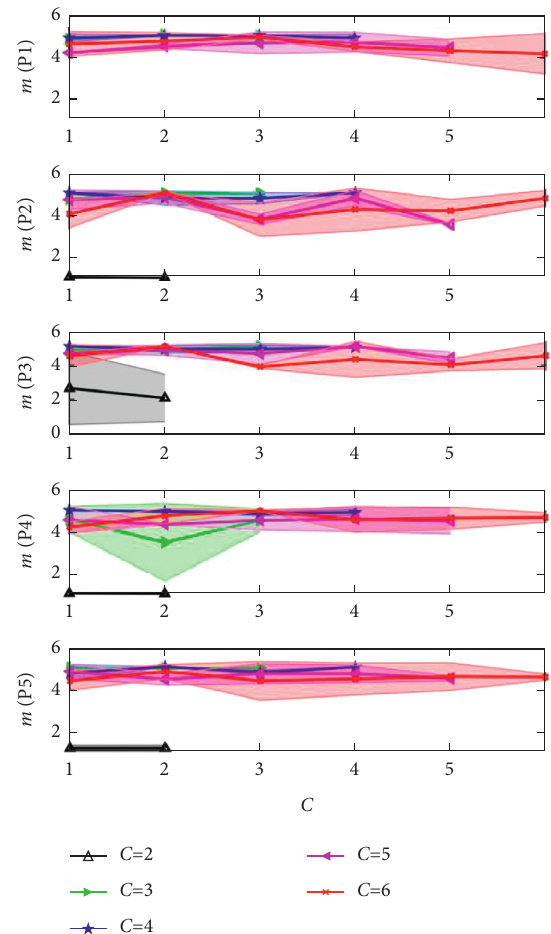
Figure 2: Performance of the dataset through clustering